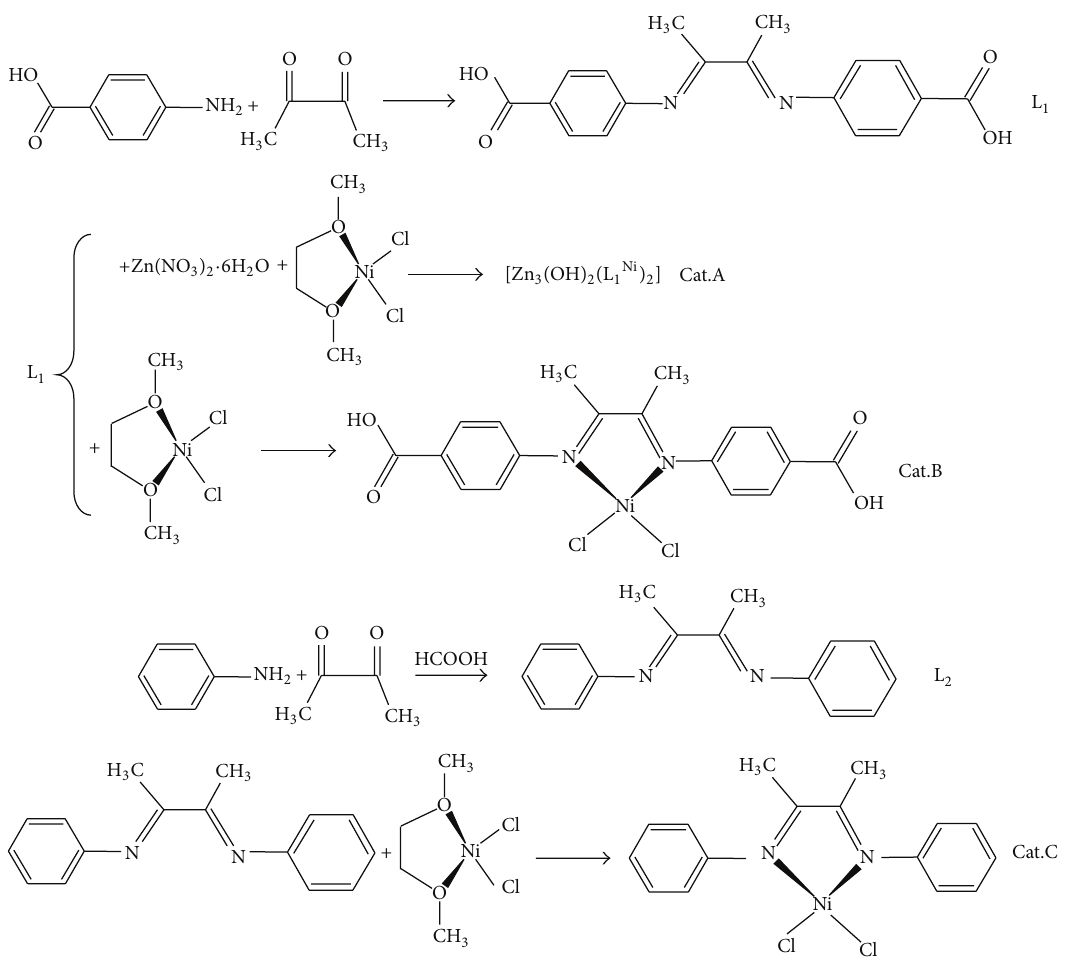
Scheme 1: Prepared processes of the three